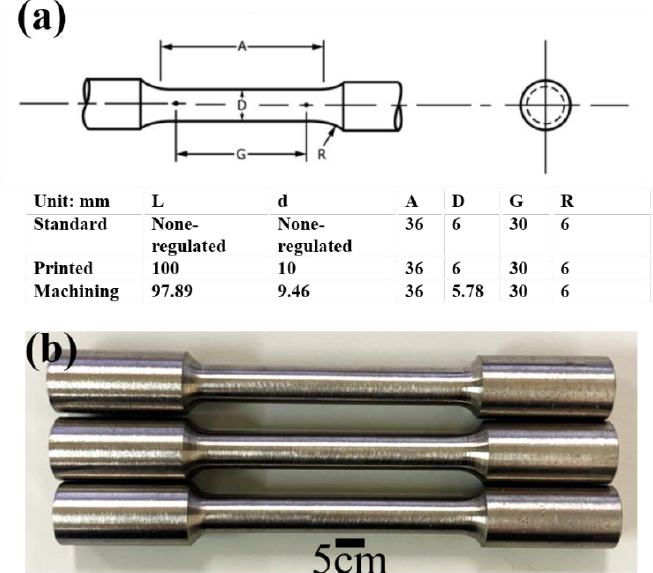
Figure A2. The cylinder test sample according to ASTM E8 standards with standard size, printed and machining size in ( a ). ( b ) The machined built tensile test samples which were built in LED parameter.